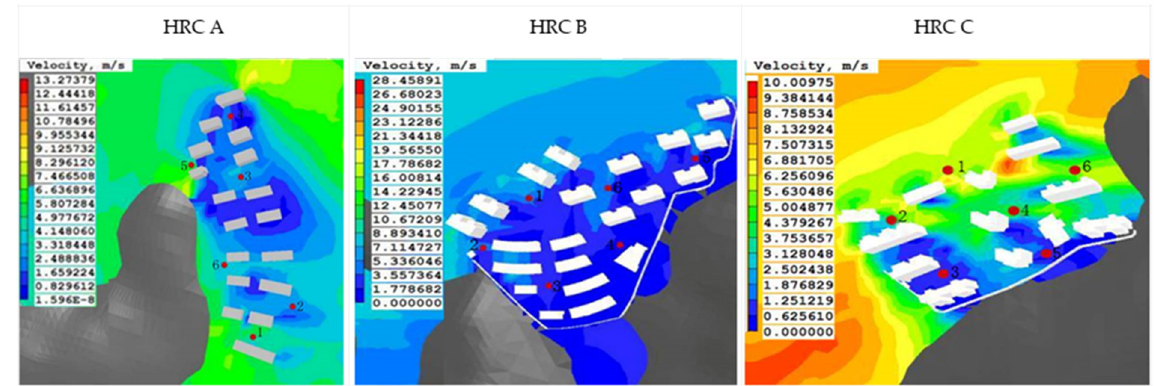
Figure 15. The simulated present wind conditions in HRC A ( left ), B ( middle ), and C ( right